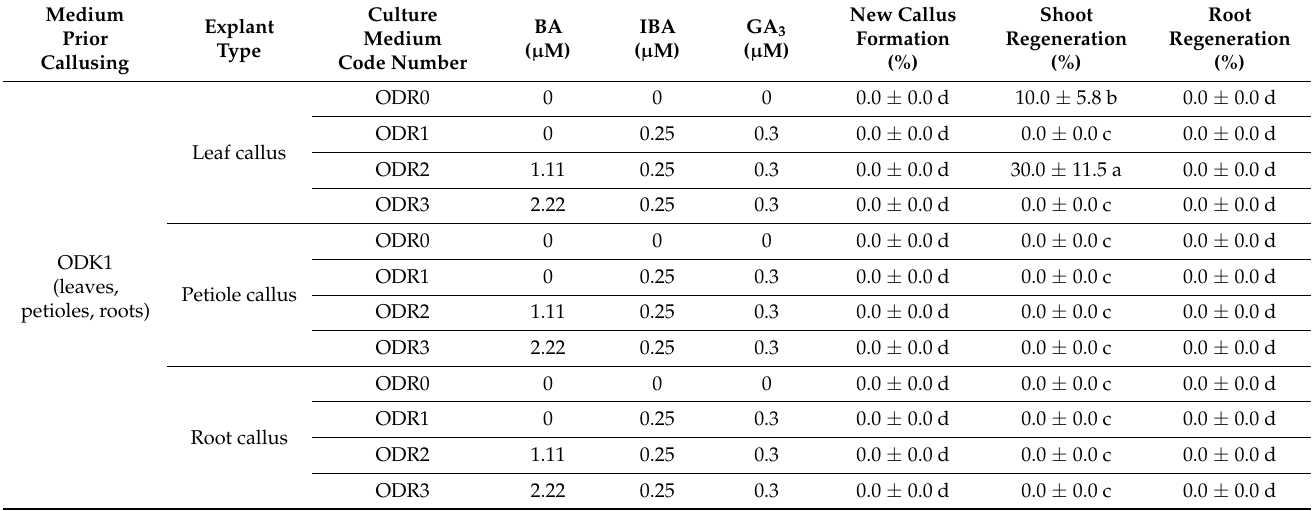
Table 2. Effect of explant type (leaf callus, petiole callus, root callus) of O. dictamnus L. and different media (ODR0, ODR1, ODR2, ODR3) on callus, shoot and root regeneration (%) (10